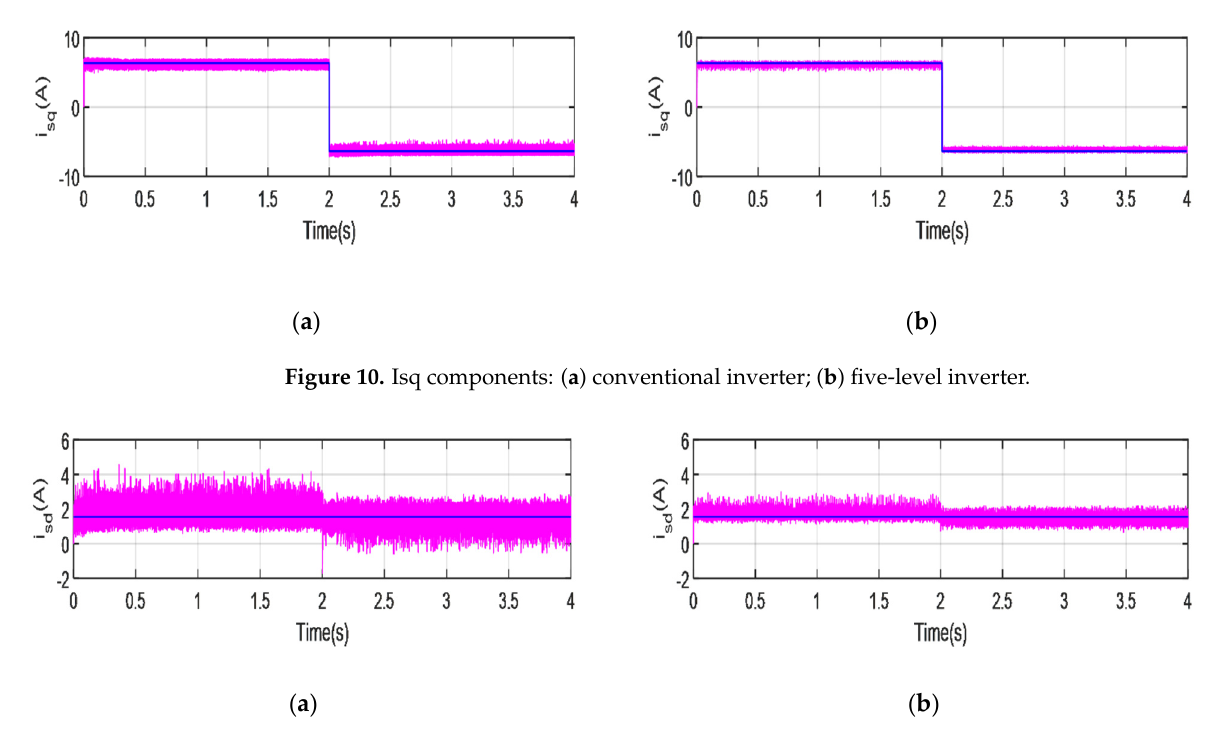
Figure 9. Stator current: ( a ) conventional inverter; ( b ) five-level inverter.